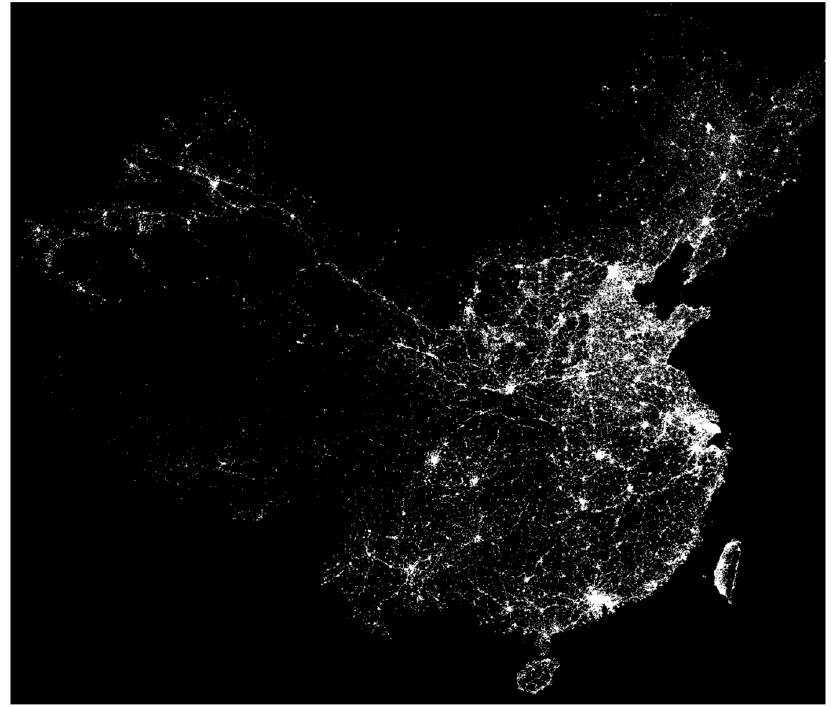
Figure 2. Nighttime light data in China.